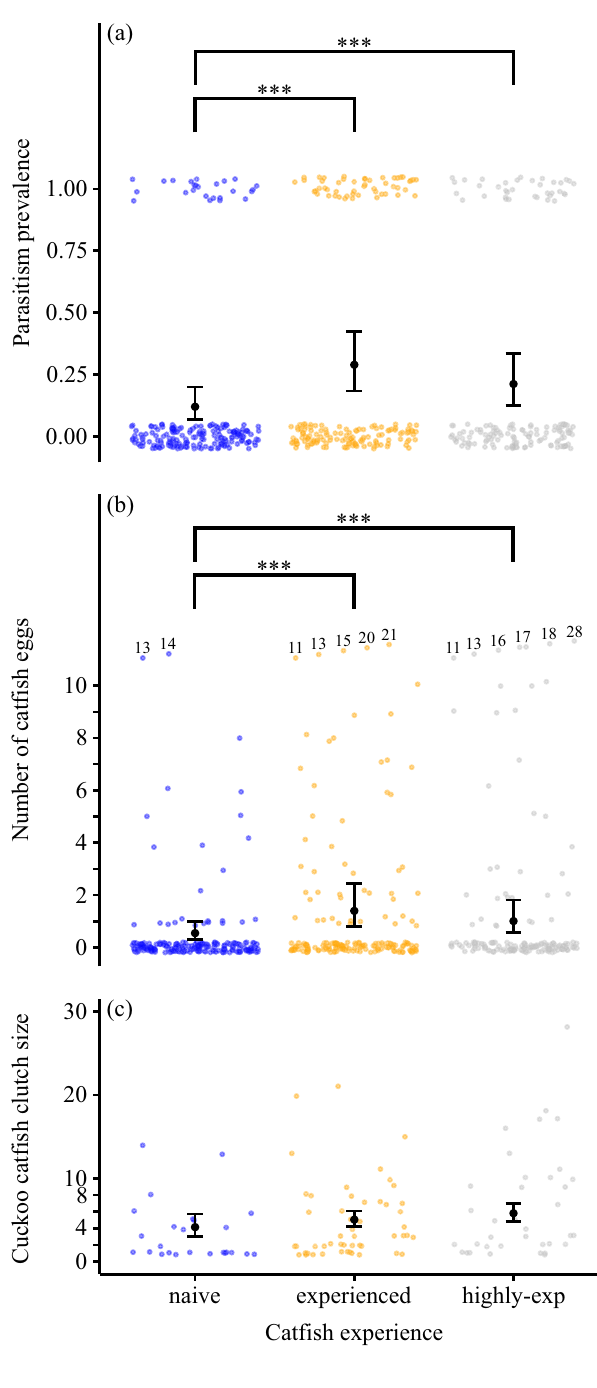
Once host defences were overcome, the number of parasitic eggs in host clutches was not affected by cuckoo cat fi sh experience (Fig. 1c, Supplementary Fig. 1). The mean cat fi sh clutch size (the number of cat fi sh eggs found within the set of parasitised clutches) did not signi fi cantly differ between naïve, experienced and highly experienced cat fi sh (mean ± S.E., naïve: enced: 6.58 ± 1.07 eggs). No pairwise difference in the mean cat fi sh clutch size was signi fi cant (GLMM with negative binomial error, host female body size and time since the start of the experiment as covariates: naïve vs experienced: z = 0.04,